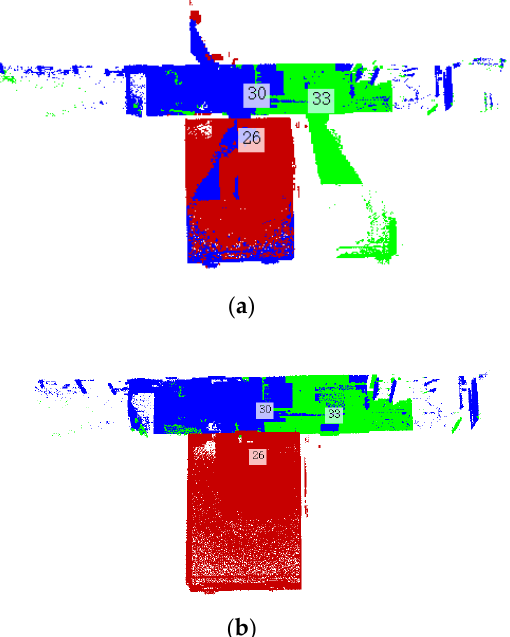
Figure 4. Simulating visible point clouds of sample trajectories. ( a ) The visible points of the three trajectory points 26, 30, and 33. ( b ) Visible points limited by door.